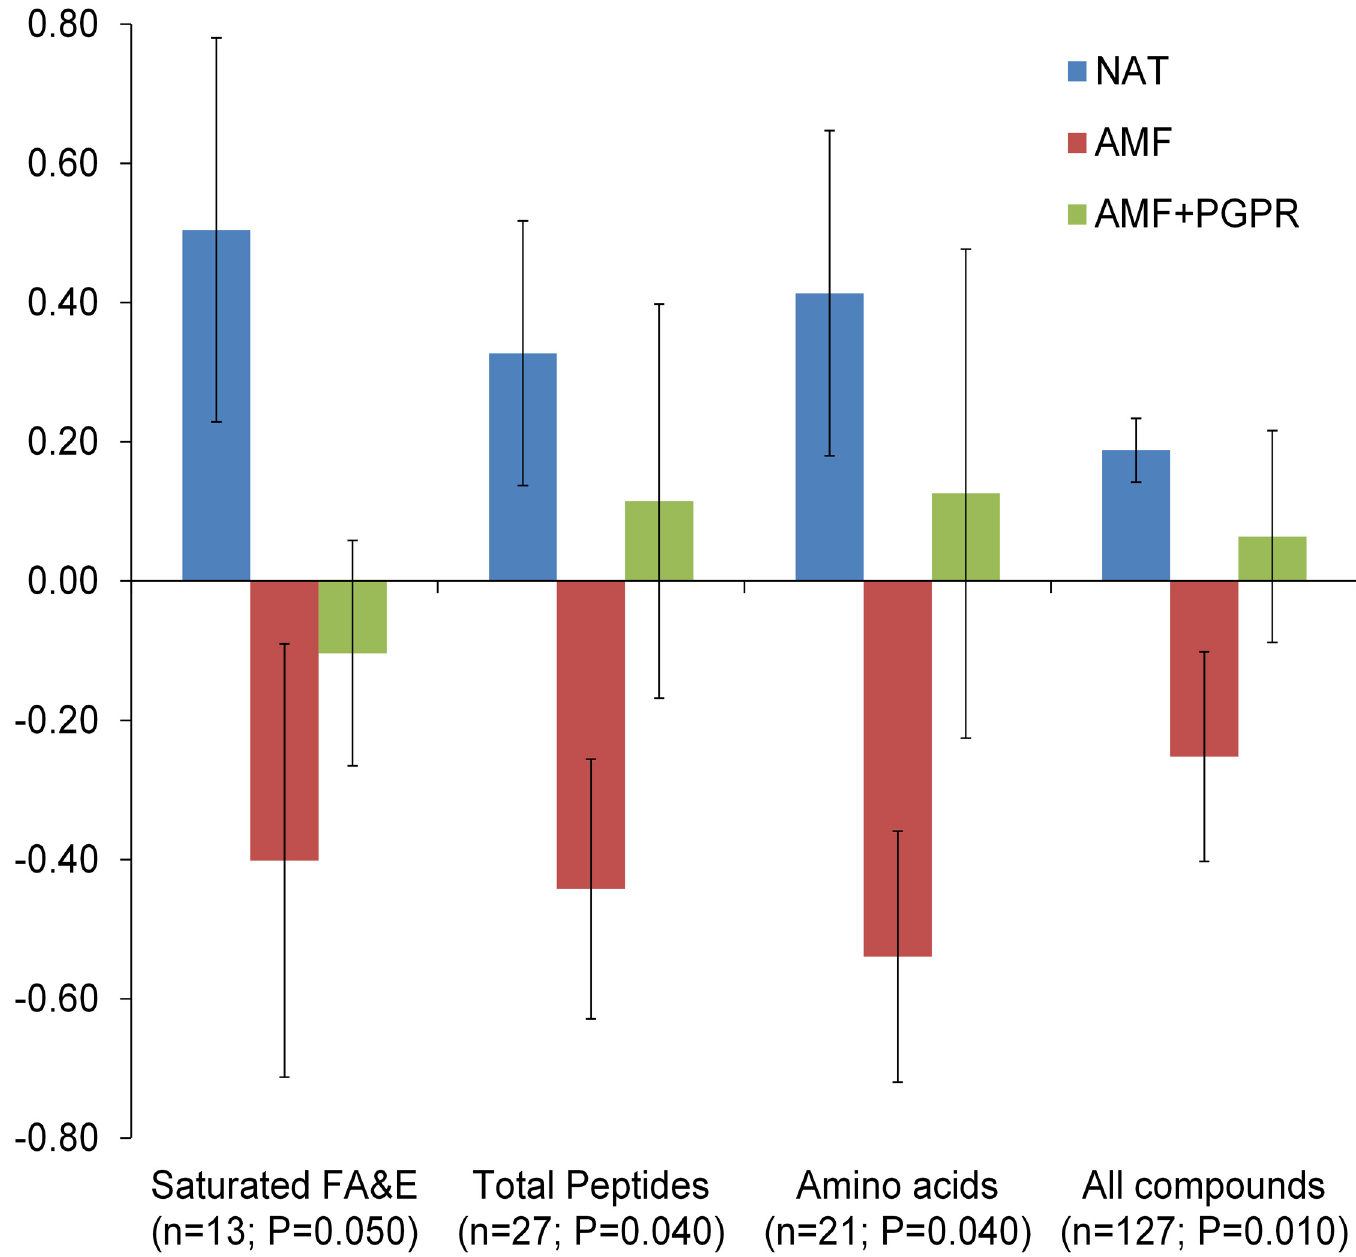
Fig 2. Group means ± S.E. across standardised data for identified GC peaks grouped per biological group significantly varying according to the treatments. n indicates the number of compounds contributing to the relative mean, and P is the P value of the ANOVA for that group. Carbohydrates were analysed separately according to KEGG annotation. All compounds includes both annotated and unannotated compounds. GC was run with methanol: chloroform:water (5:2:2) extracts from roots of durum wheat grown in the field with natural arbuscular mycorrhizal inoculum (NAT), inoculation with AM fungi (AMF), or inoculation with both AMF and plant growth — promoting rhizobacteria (PGPR). FA&E, fatty acids and their esters. Please see Table G in S1 File for non-significantly varying classes of compounds.